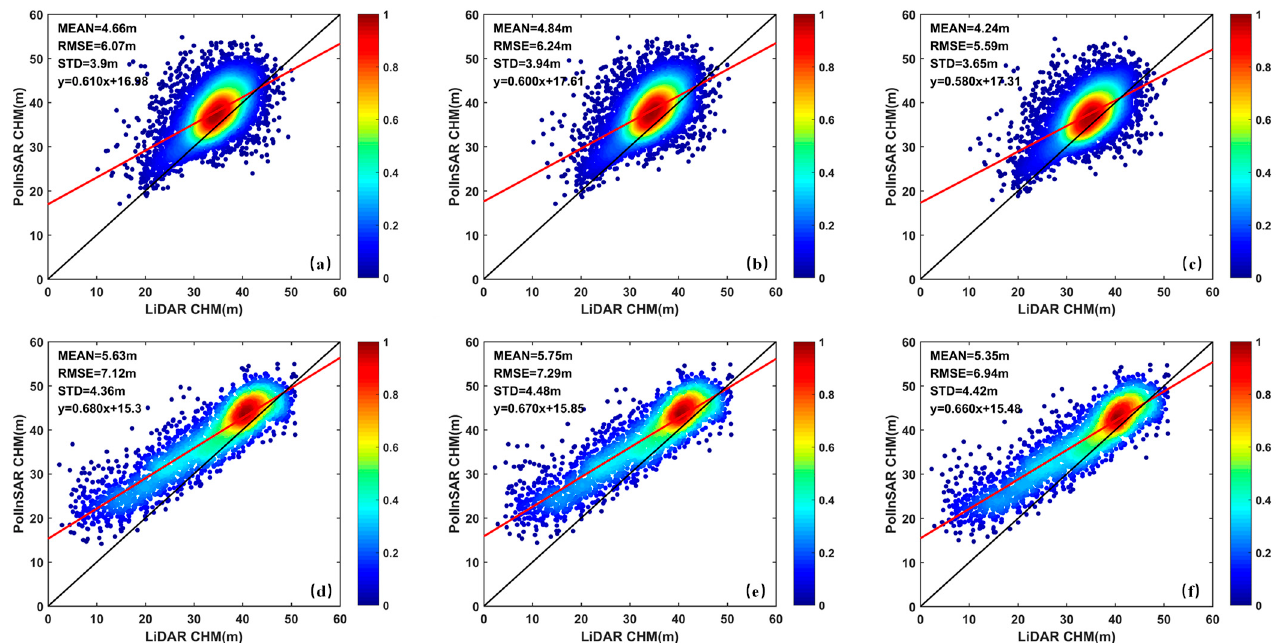
Figure 14. The relationships between the LiDAR and PolInSAR heights for different filtering methods in the Mabounie and Mondah areas: ( a ) Boxcar filtering in the Mabounie area; ( b ) IDAN filtering in the Mabounie area; ( c ) refined Lee filtering in the Mabounie area; ( d ) Boxcar filtering in the Mondah area; ( e ) IDAN filtering in the Mondah area; ( f ) refined Lee filtering in the Mondah area.